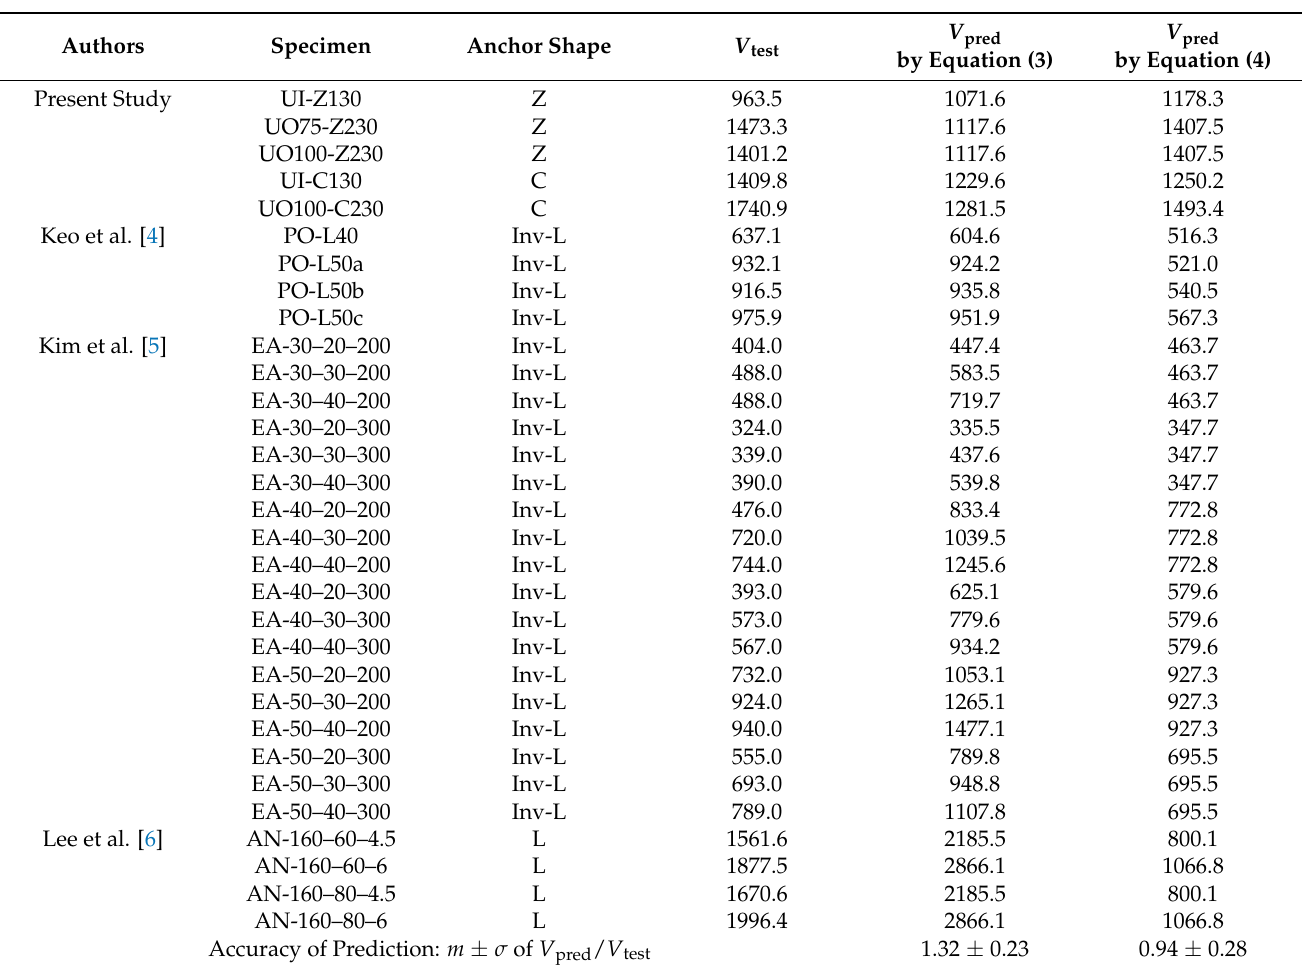
Table 5. Comparison of Test Results with Predictions by Existing Design Equations for Channel Anchor with Partial-length Welding (units in